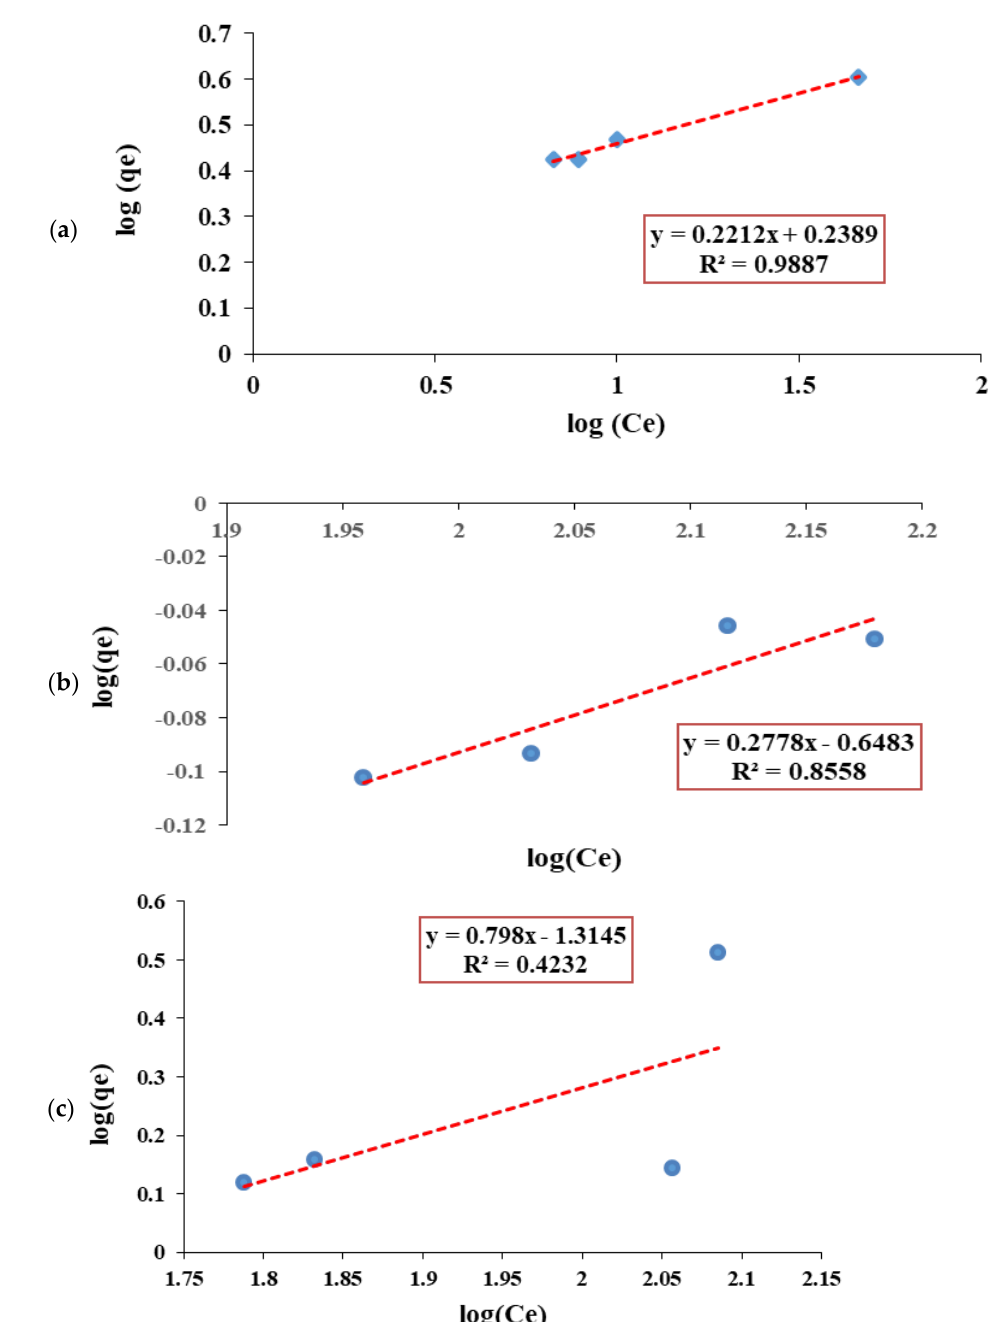
Figure 16. Linear form of Freundlich isotherm model for the adsorption of calcium ions by ( a ) zeo- ( b ) activated carbon, and ( c ) activated lite, ( b ) activated carbon, and ( c ) activated alumina. Table 4. Correlation coefficient and constant values of the isotherms for the adsorption of calcium ions by different adsorbents.